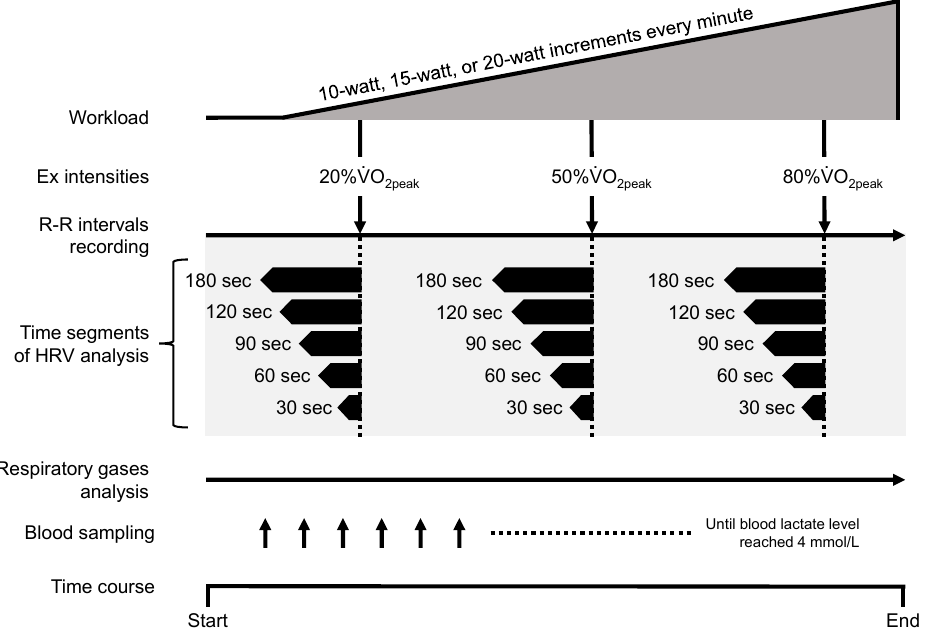
Figure 1. The experimental protocol and the adoption of HRVs corresponding to each level of exercise intensity. The black range in the time segment of HRV analysis indicates the time length of HRV analysis from each exercise intensity (20%, 50%, or 80% V participant were performed using the same R–R intervals recording data. The up arrow indicates the sampling point of blood. Ex, exercise; HRV, heart rate variability; sec, seconds; V oxygen uptake.